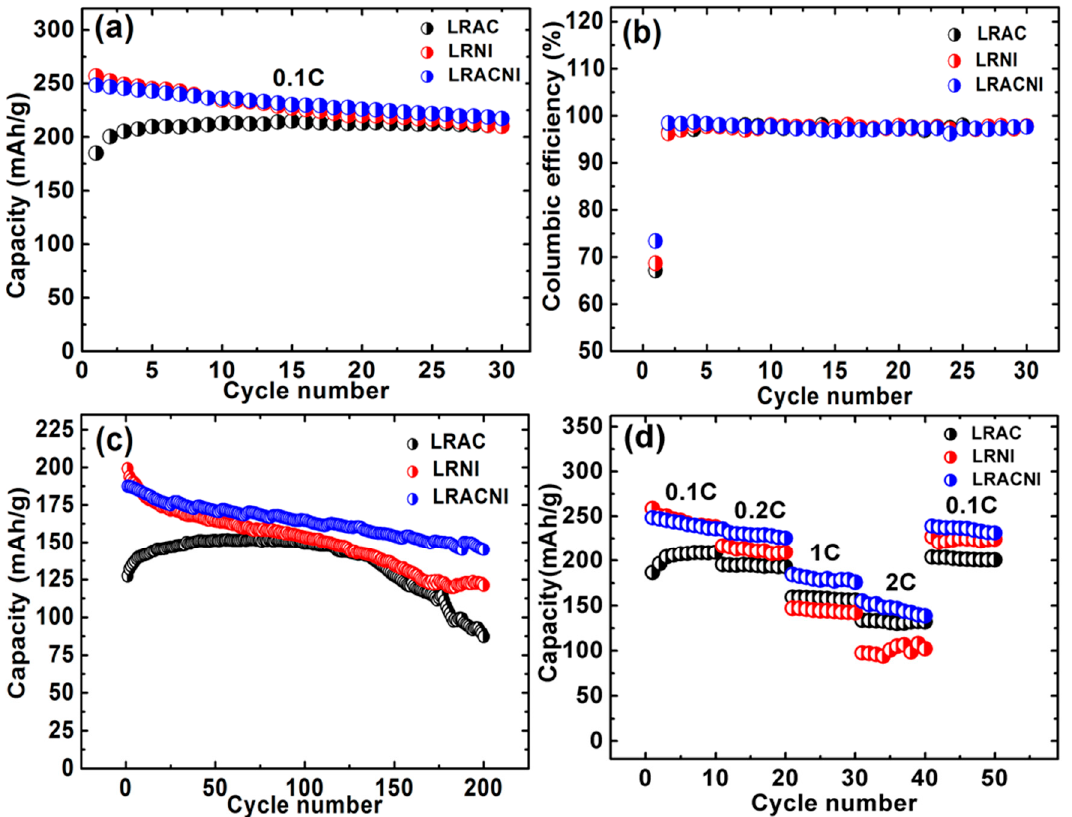
Figure 7. ( a ) Discharge capacities at 0.1 C; ( b ) Coulumbic efficiency at 0.1 C; ( c ) Discharge